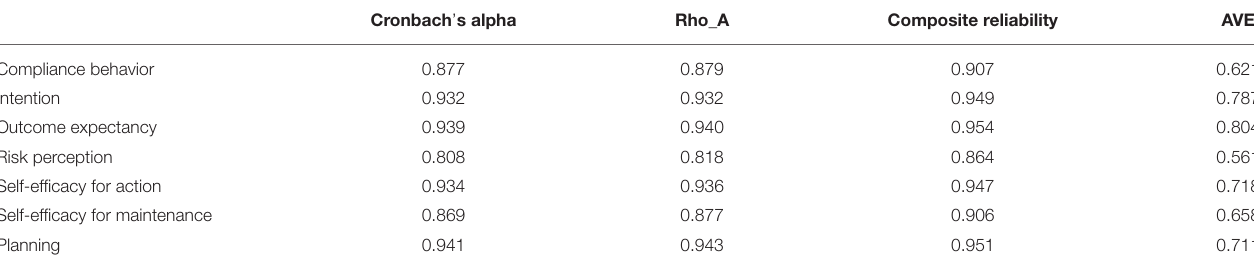
TABLE 3 | Reliability and convergent validity of the whole measurement